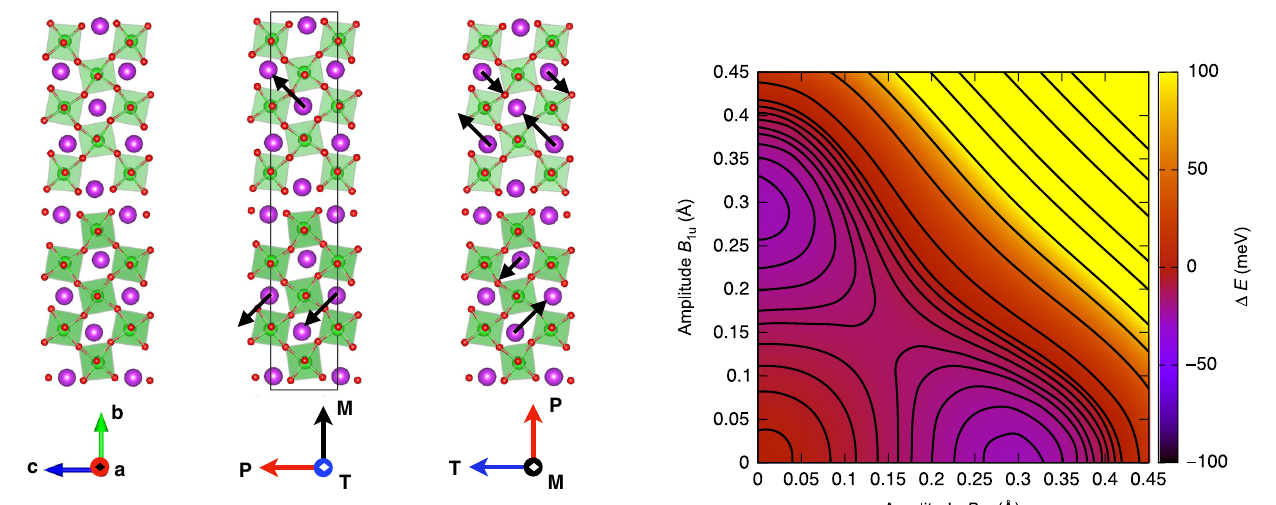
Fig. 1 Comparison of high-symmetry and distorted structures. High- symmetry unstable ( a ) and distorted ground-state stable ( b ), ( c ) structures of BiMO. The crystal axes, the main local ionic dipoles, and the order- parameter vectors in the different states are shown.